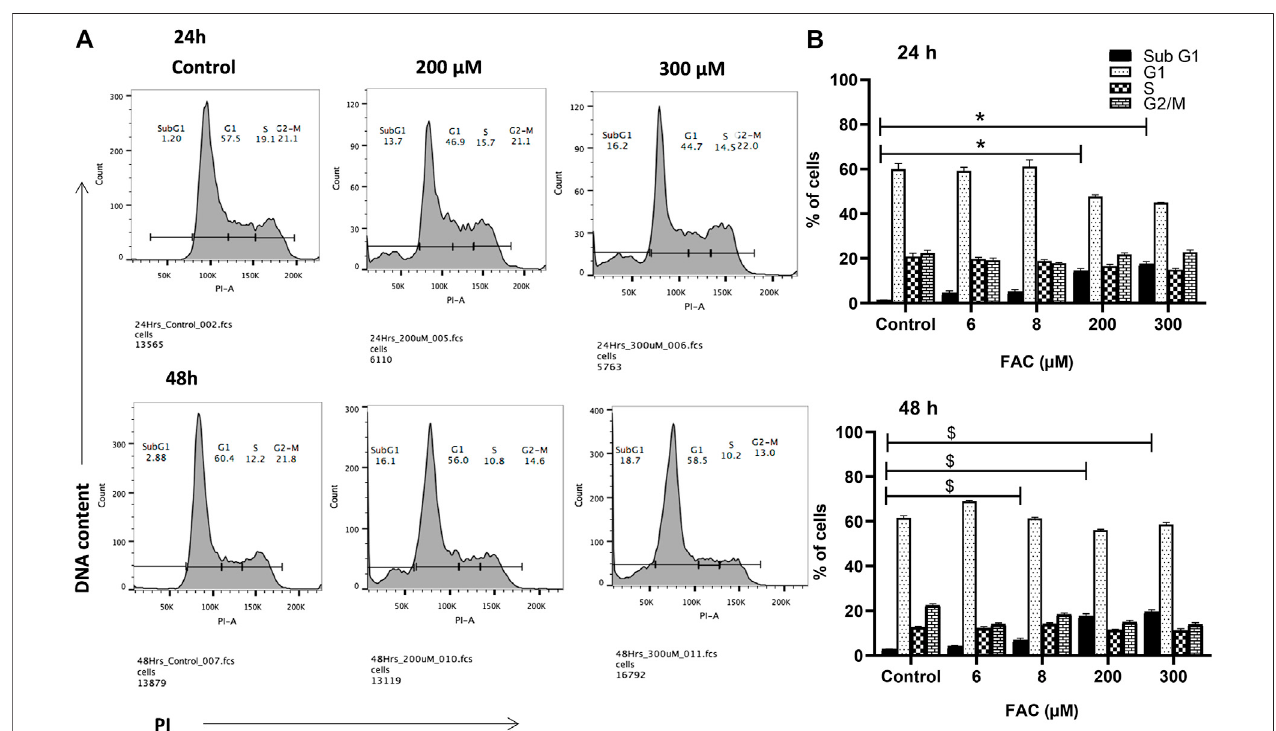
FIGURE 2 | Iron overload and cell cycle progression analysis in chondrocytes. Cell cycle progression of C-20A/4 cells was examined following treatment with 200 and 300 µM of FAC and 24 or 48 h using the PI staining fl ow cytometry-based method. (A) Cell cycle pro fi le in FAC-treated and control C-20A/4 cells; data shown are representativeofthreeindependentexperiments. (B) Calculateddistribution ofcell-cycle-relatedsubpopulationsbasedonthreeindependentexperiments with±SD;*, $ denotes statistical signi fi cance at p < 0.05 as per the indicated group vs . its untreated control at 24 and 48 h respectively. Untreated cells cultured under the same conditions served as negative